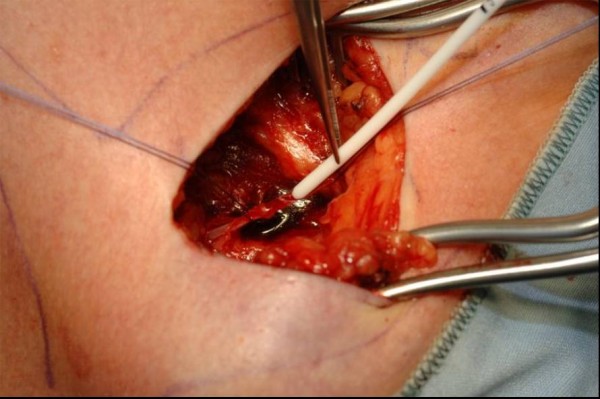
Venae Sectio – introducing of TIAP catheter.